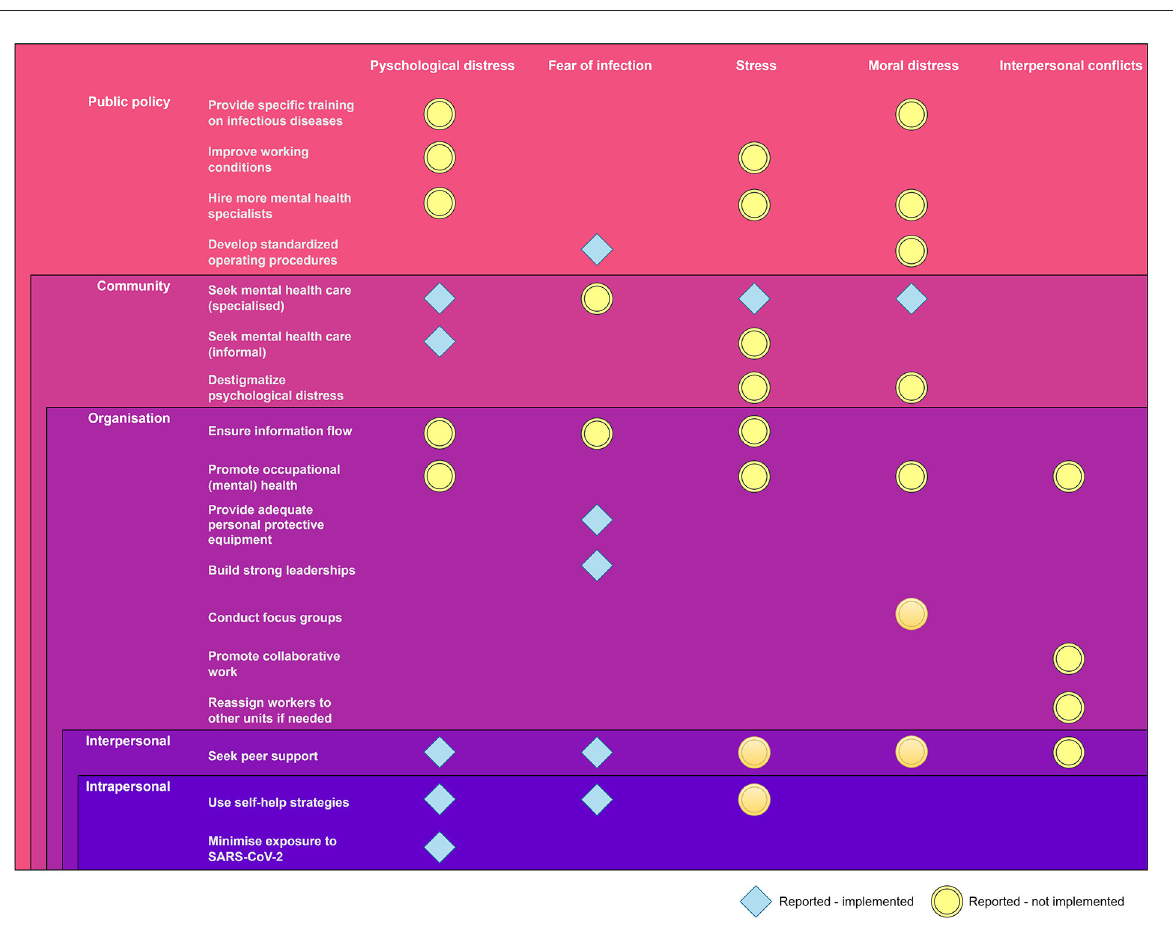
and moral distress (“Normalize the situation, you are not on your own, and many have been through the same thing as you; together, we can improve people92s resilience and resist without tearing apart”